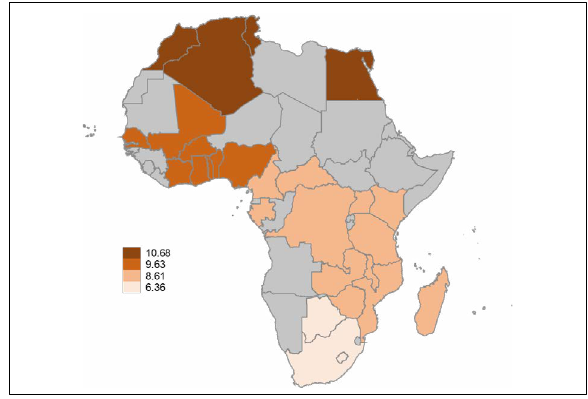
Women respondents’ average career-challenge score, by region, from lowest to highest: Southern Africa, Eastern and Central Africa, Western Africa, and North